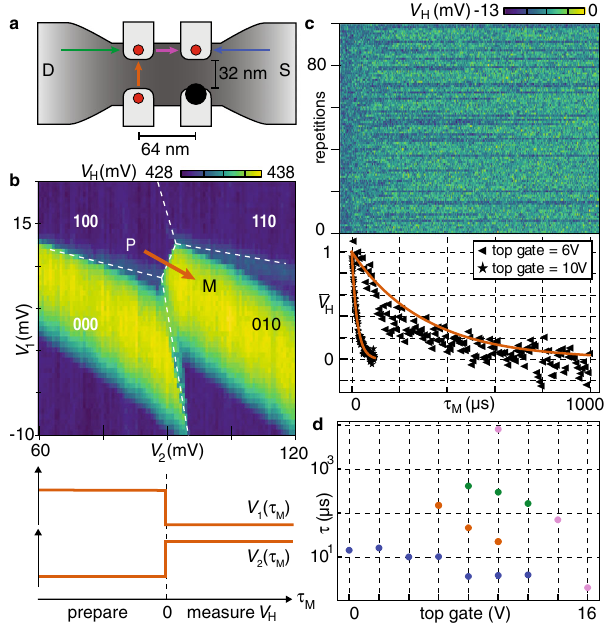
Fig. 3 Pulsed-gate charge manipulation, single-shot readout, and tunability of tunnel couplings. a Device schematic indicating the lead-to- dot (green and blue) and interdot (orange and magenta) transitions for the fi rst electron. The arrows indicate the directions of the tunneling events studied. b Illustration of a V 1 – V 2 gate-voltage pulse (orange) that moves an electron from dot 1 to dot 2, with V 4 fi xed such that a tunneling event causes a change in the sensor signal V H (color scale). For each pulse, digitization of V H ( τ M ) begins when the gate-voltage switches from preparation point P to measurement point M. c Single-shot traces V H ( τ M ) for 100 pulse repetitions, with top gate fi xed at 6 V. An exponential decay (orange), fi tted to the normalized average of all traces ( ◂ ), yields a characteristic tunneling time of 300 μ s, and is compared with data obtained with the top gate fi xed at 10 V ( ⋆ ). Analogous data for the other transitions in a are shown in Supplementary Fig. S2. d Tunneling times for the transitions indicated in a , as a function of the top-gate